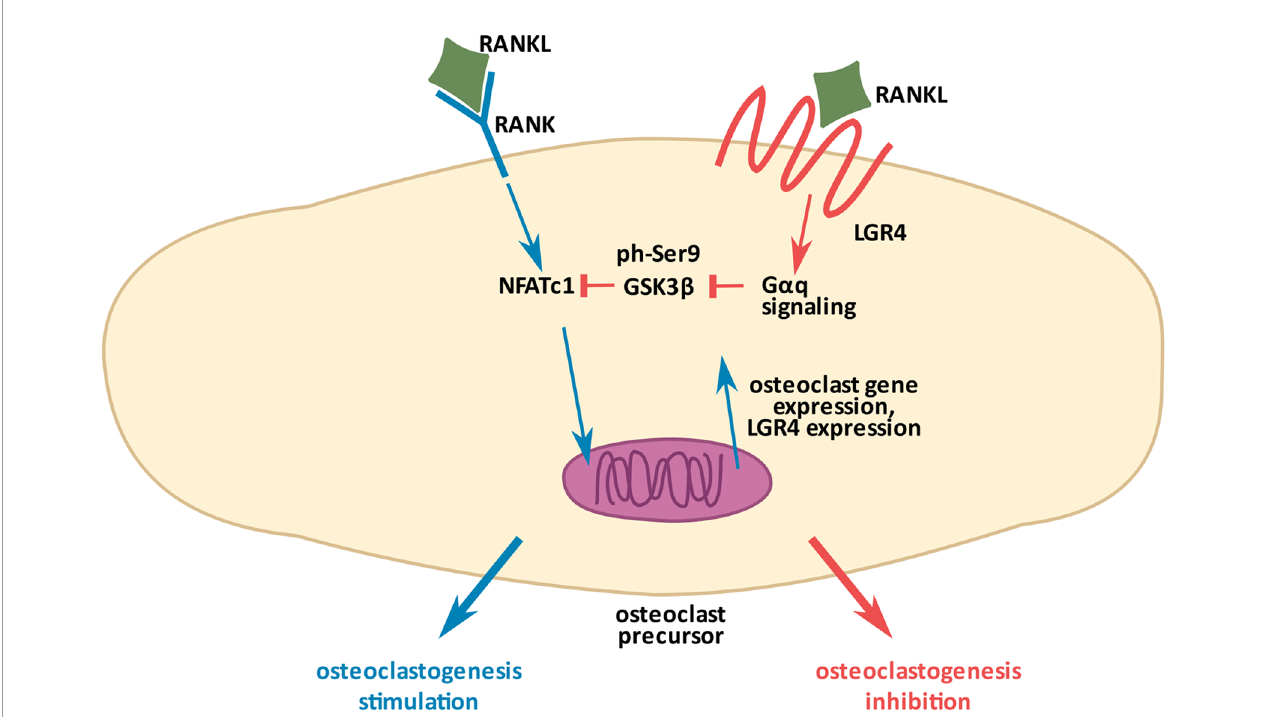
FIGURE 2 | Molecular mechanism of osteoclastogenesis inhibition by LGR4. RANKL (Ligand of Receptor-Activator of NF k B), a common ligand for the two receptors, RANK (Receptor-Activator of NF k B) and LGR4, has opposite effects on osteoclastogenesis. RANKL/RANK interaction (depicted in blue arrows) promotes the process through NFATC dephosphorylation, which allows it to enter the nucleus and stimulate gene expression for osteoclastogenesis. RANKL/LGR4 interaction (depicted in orange), on the other hand, inhibits osteoclastogenesis through activation of G a q-mediated signaling to stabilize GSK3 b and prevent its phosphorylation (inactivation). Activated GSK3 b phosphorylates NFATC preventing its entry into the nucleus, thus inhibiting osteoclastogenesis. Excessive stimulation of the RANKL/ RANK pathway induces Lgr4 expression as a negative feedback mechanism to fi nely control the process